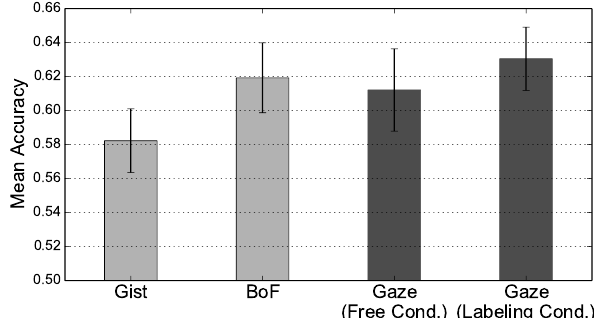
Figure 6 . Performance comparison based on free viewing. The rightmost graph shows the mean accuracy, where the data from the labeling phase were used as the training data and the classifier was tested against the data from the free viewing phase. The first two graphs show the mean accuracy of the two image-based classifiers, and the third graph shows the results when using the data from the free viewing phase for both the training and